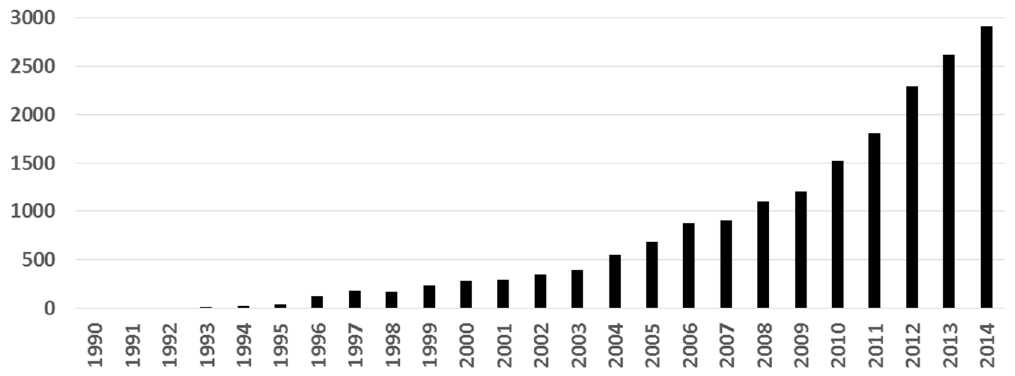
Figure 1. Number of publications where molecular docking was used (search in Scopus).